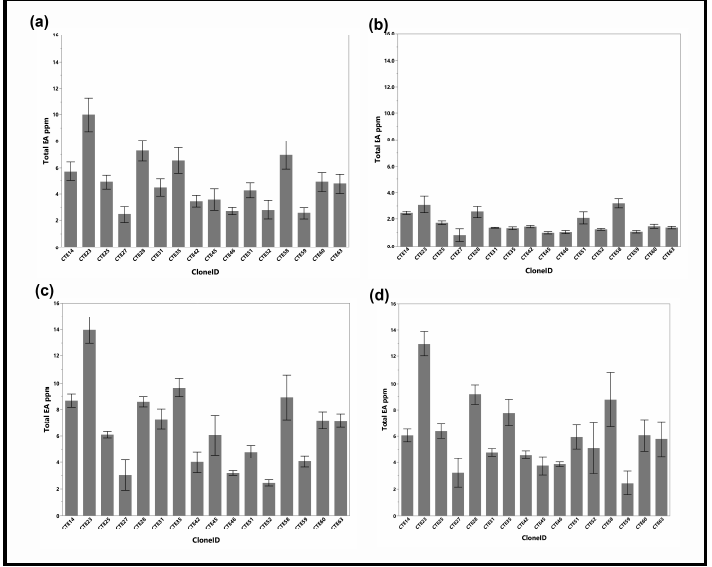
Figure 2. Seed head ergot alkaloid (Total EA) levels in 16 CTE tall fescue clones ( a ) averaged over three years of study, and for ( b ) 2017, ( c ) 2018 and ( d ) 2019 individually. Data are means +/ − 1 s.e. A similar genotypic difference was observed in the accumulation of loline alkaloids (Figure 3). Total loline levels across all years were seen to be lowest in CTE27, CTE46 and CTE63 and highest in CTE23, CTE28 and CTE58 (Figure 3a). This pattern was consistent across each year (Figure 3b–d). The levels of the different lolines varied based on geno- type (Figure 4a–c). Interestingly, CTE28 appears to have significantly lower levels of the loline alkaloid N-acetylloline (NAL) (Figure 4c). While the biosynthetic pathway from N-acetylnorloline (NANL) to NAL is still not known, it is postulated not to be fun- gal-derived, but produced via a plant acetyltransferase [33]. Agronomy 2023 , 13 , 356